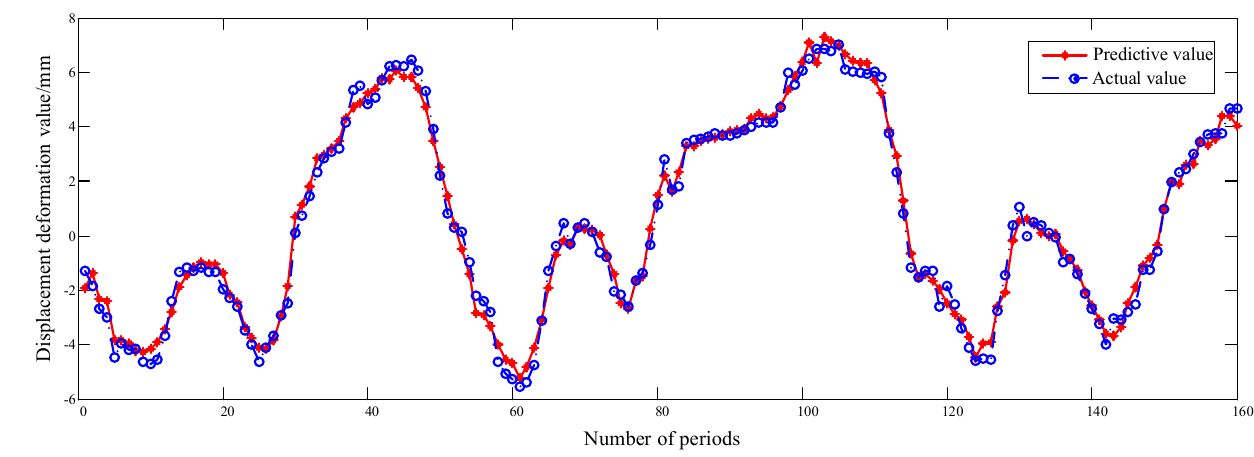
Figure 9. Horizontal displacement fitting of dam training samples.